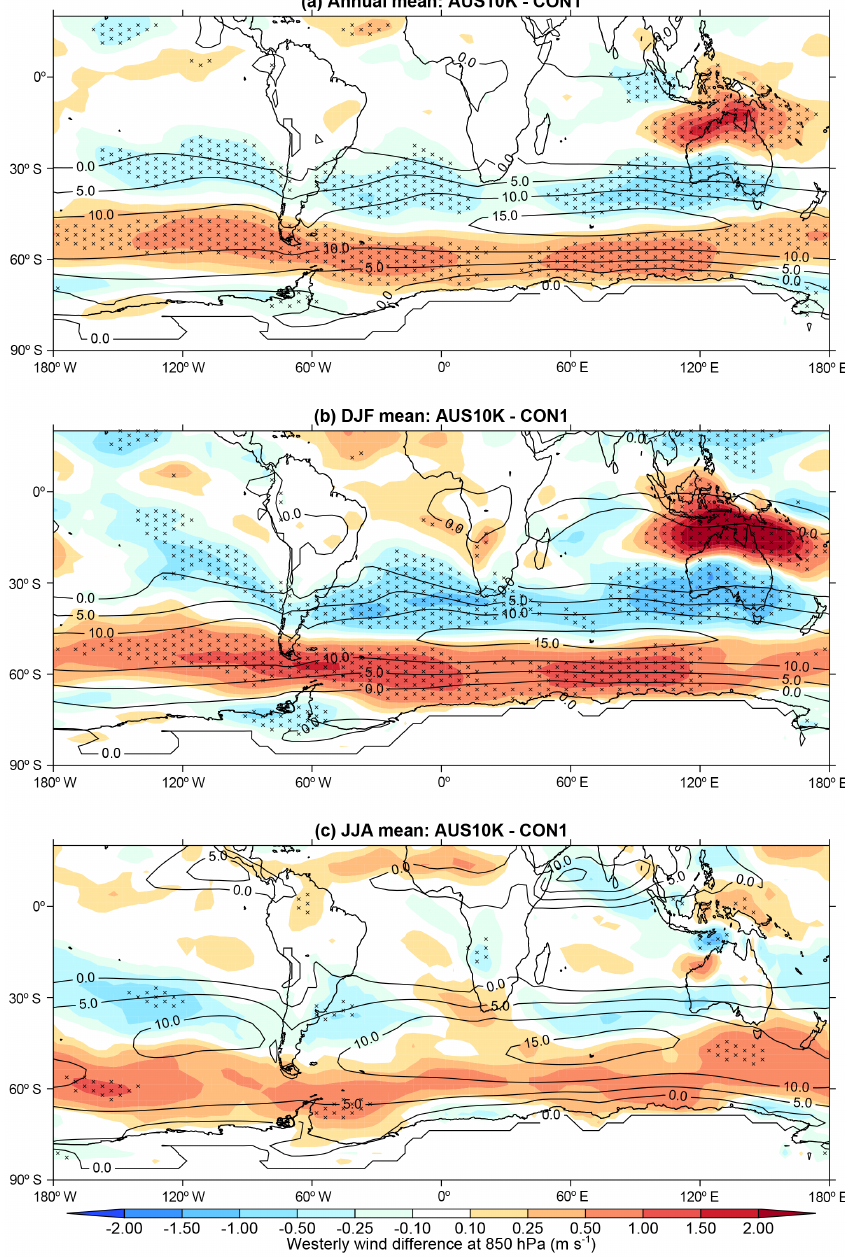
Figure 10. The difference in the 850hPa zonal flow (ms − 1 ) in AUS10K relative to CON1 for the (a) annual mean, (b) DJF mean, and (c) JJA mean (shaded). Overlaid (solid contours) is the mean zonal flow in CON1 to highlight the location of the westerly jet at 850hPa. Values of p ≤ 0.05 are denoted with an